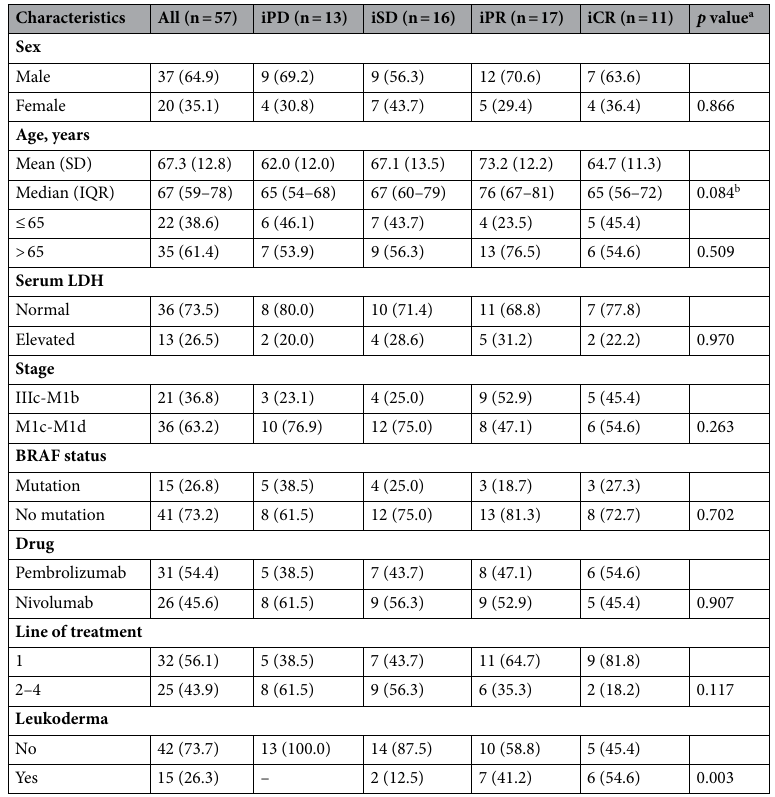
Table 2. Patient characteristics, treatments, and leukoderma development. Totals may vary because missing values. Data are n (%) unless otherwise stated. iPD progressive disease, iSD stable disease, iPR partial response,